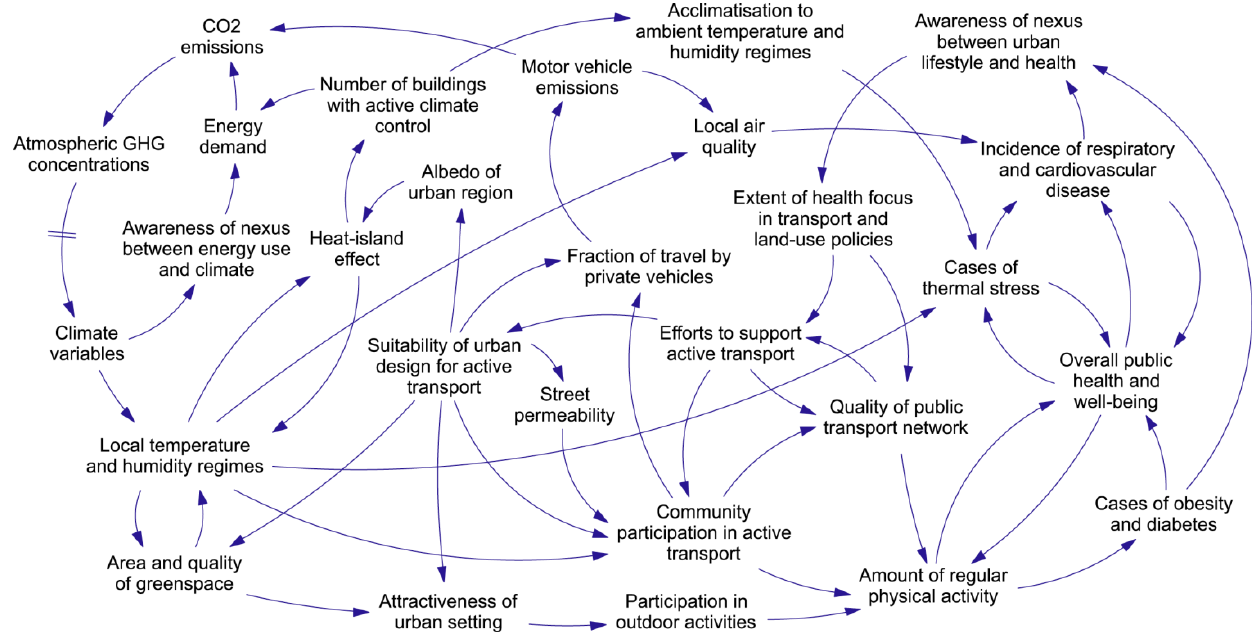
Figure 2. An hypothesis concerning selected aspects of the causal structure of urban climate-health systems. In this influence diagram the blocks of text represent system variables, and the arrows represent causal links.